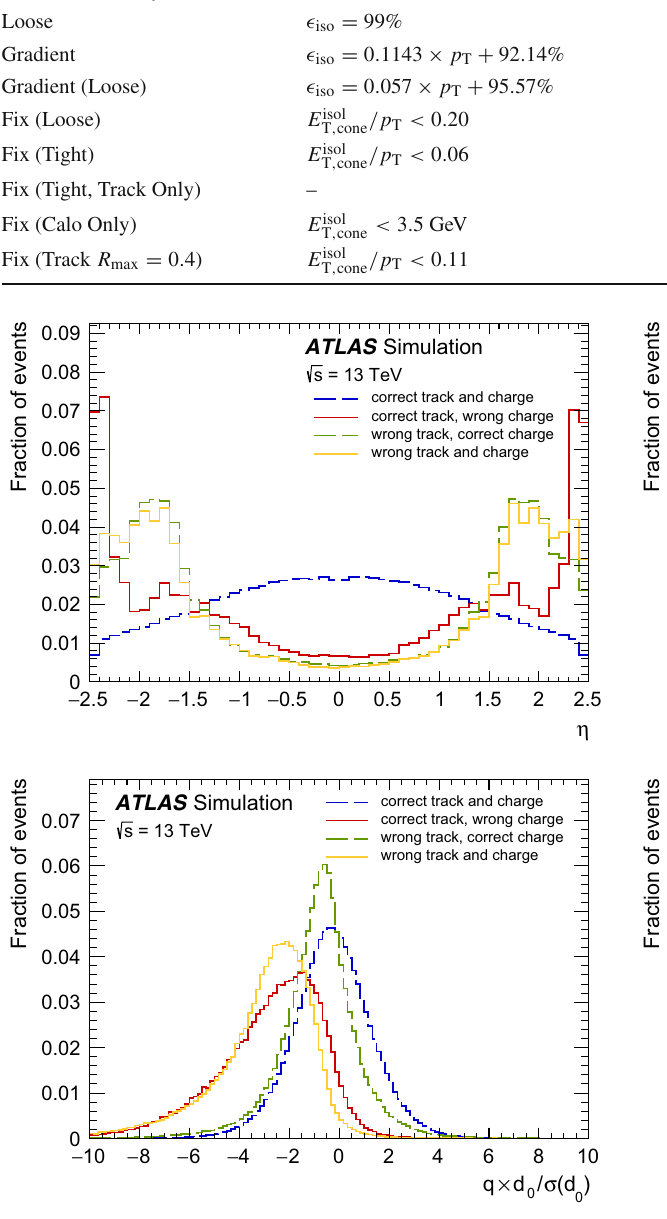
incorrectly reconstructed charge with respect to the particle that caused the track and the correctly and incorrectly assigned track with respect to the primary electron. The distributions are normalised to the same